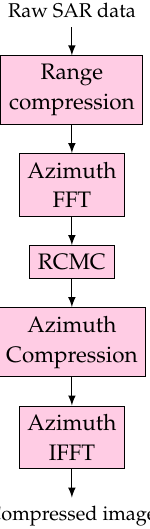
Figure 4. Block diagram of the Range–Doppler Algorithm, from